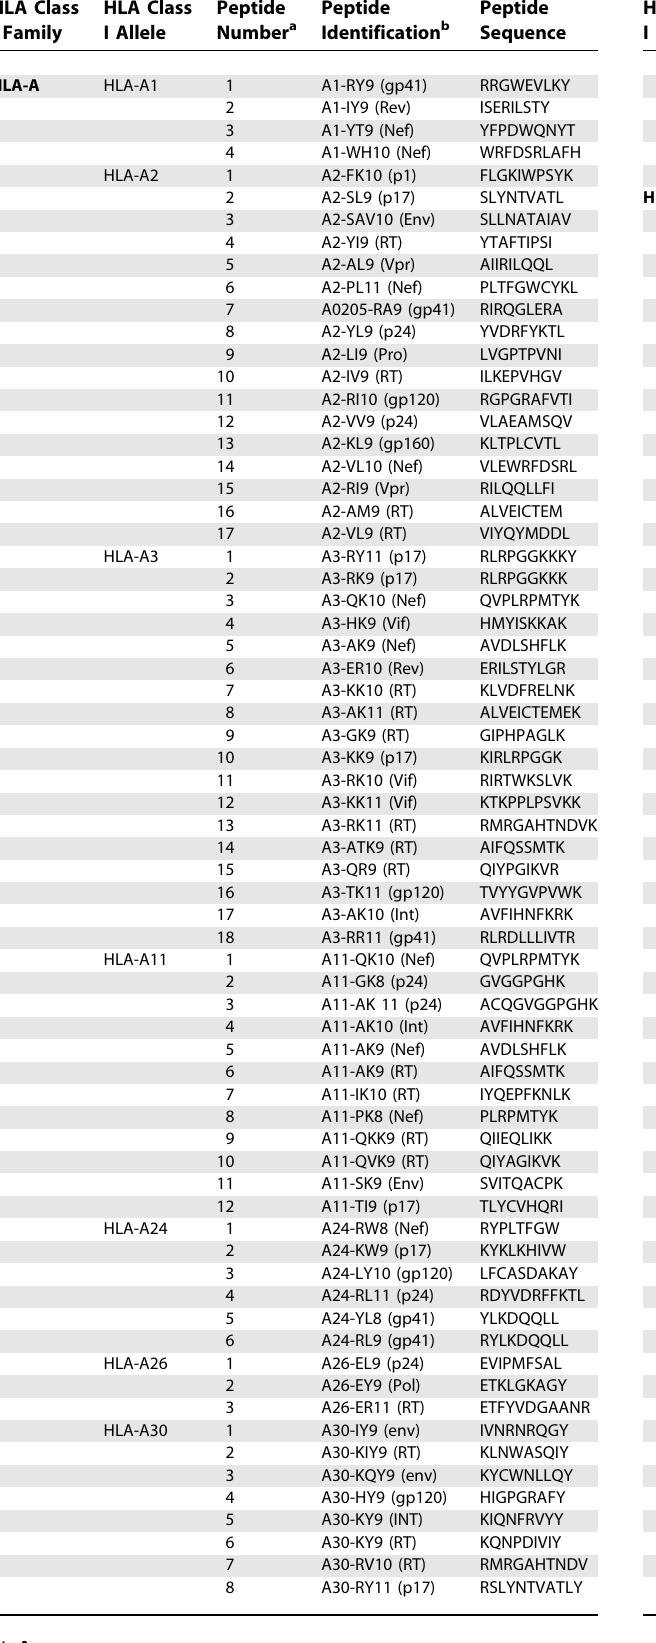
Table 2. HIV-1-Specific CD8 þ T Cell Epitopes